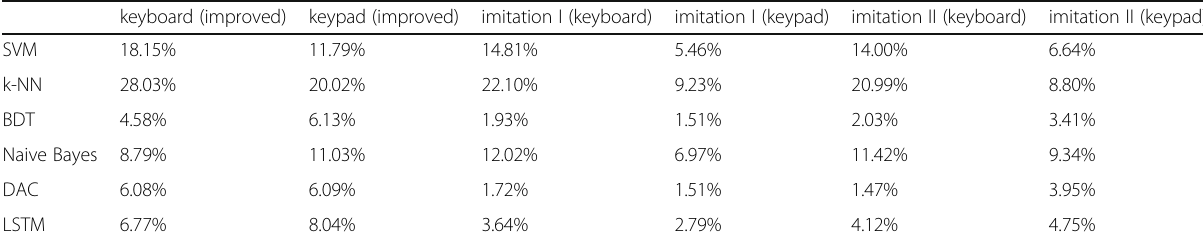
Table 2 FRR in different